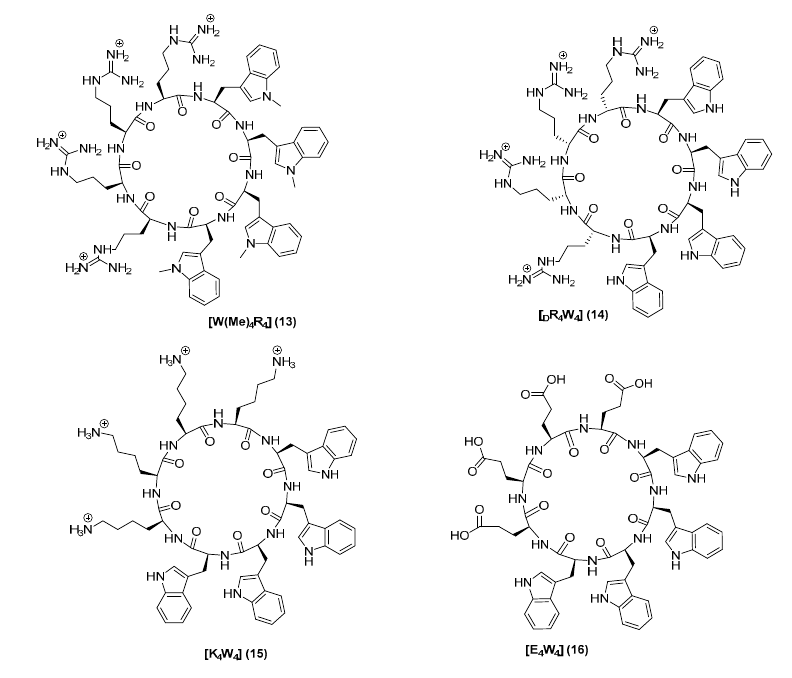
Figure 3. Chemical structures of cyclic peptides.